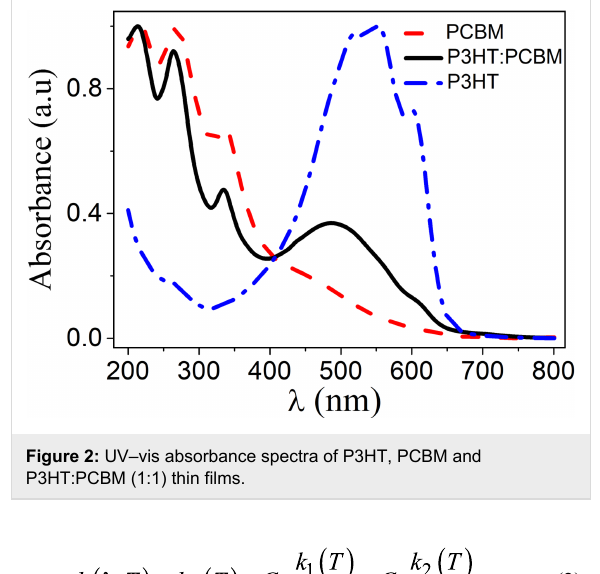
Figure 2: UV–vis absorbance spectra of P3HT, PCBM and P3HT:PCBM (1:1) thin